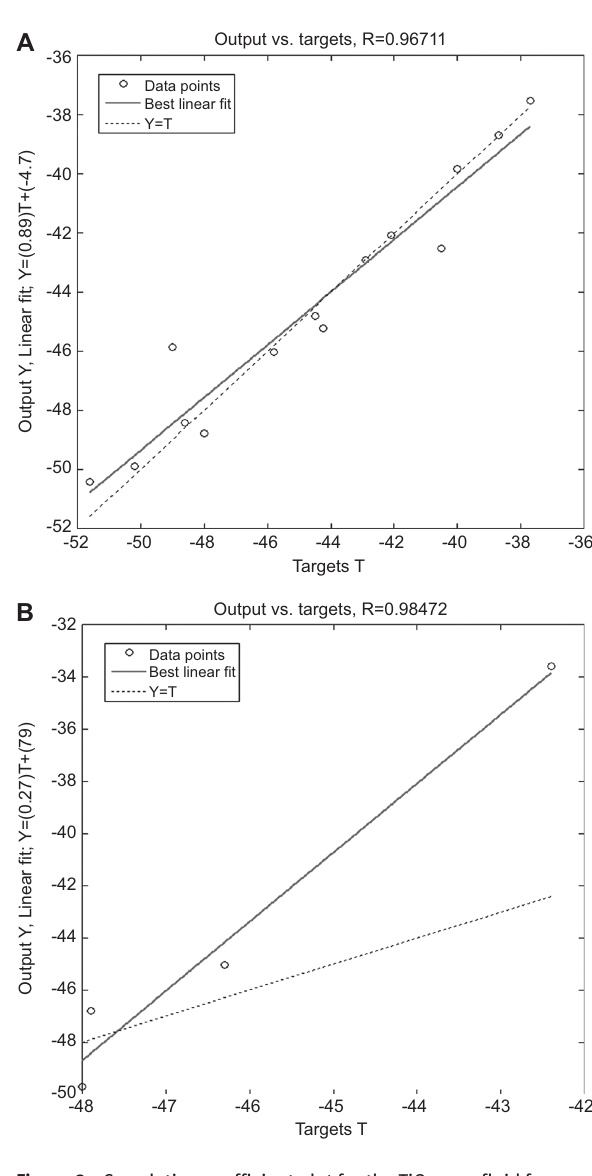
nanofluid for 2